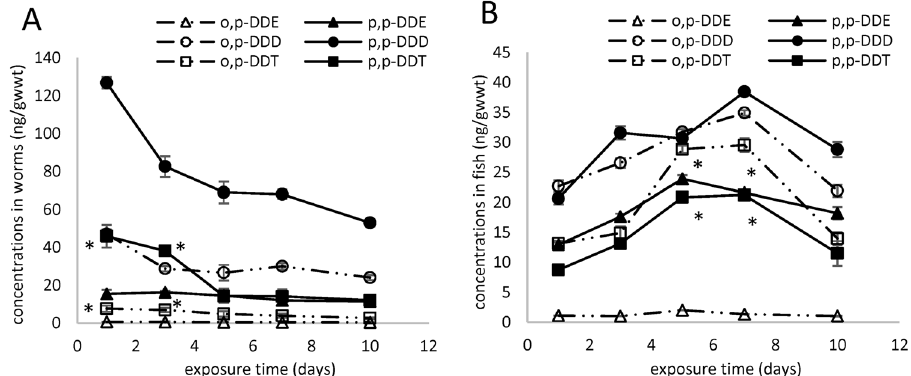
Figure 4. The eilimination of DDTs in T. tubifex ( A ) and carp ( B ). * Indicates significant difference between p,p’-DDT and o,p’-DDT ( p < 0.05, S-N-K